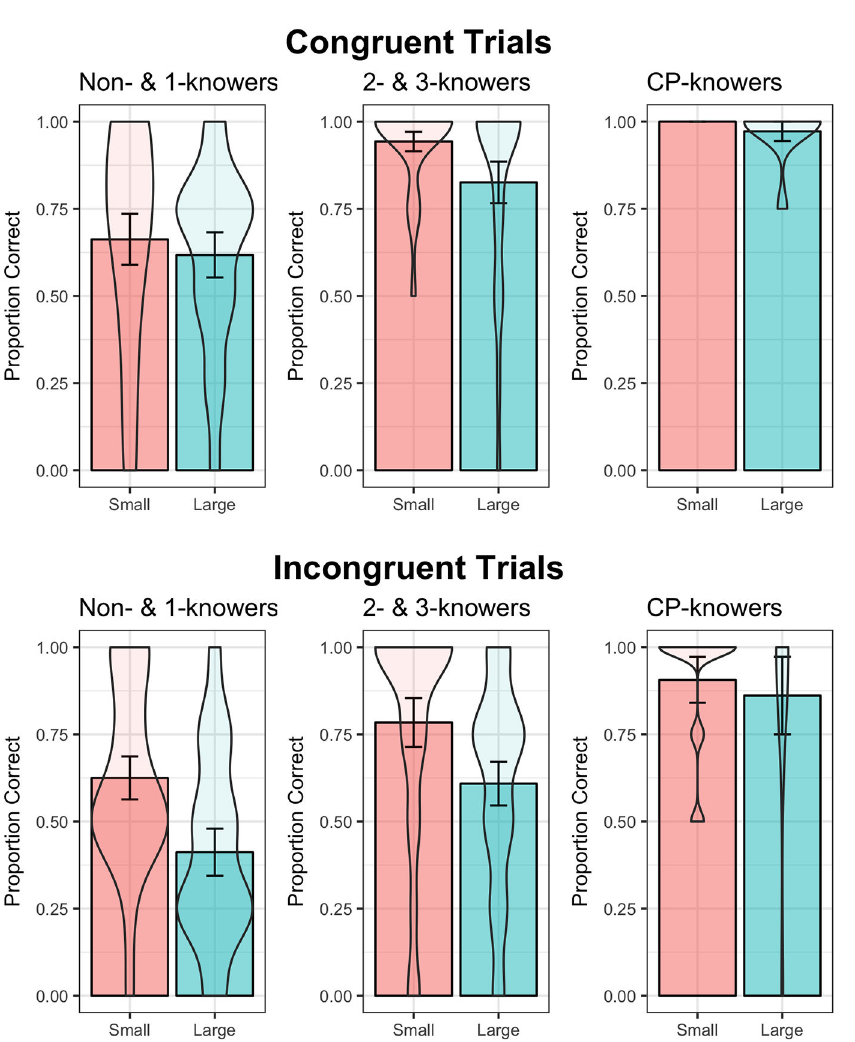
Figure 2. Overall proportion correct on small and large numerosity comparisons on congruent trials (top panel) and incongruent trials (bottom panel), separated by knower-levels in Experiment 1. Violin plots are used to depict the distribution and probability density of the data. Error bars represent standard errors of the